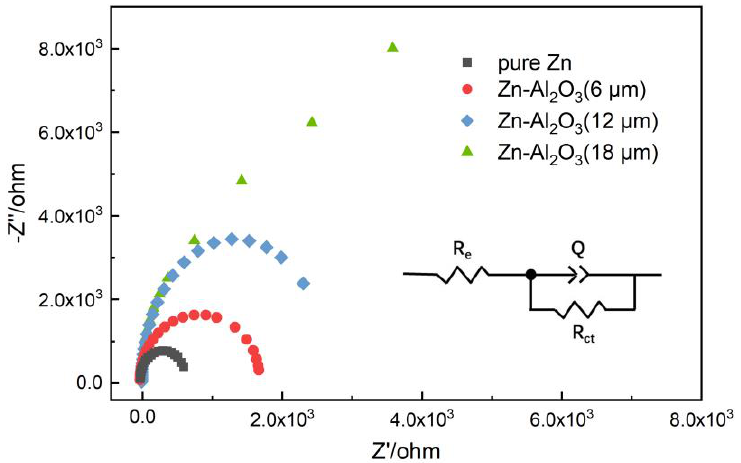
Figure 6. Nyquist plots obtained by EIS for the bare and different thicknesses of Al 2 O 3 -coated zinc substrates in 4 M KOH solution. Inset: The equivalent circuit model for fitting the impedance data .